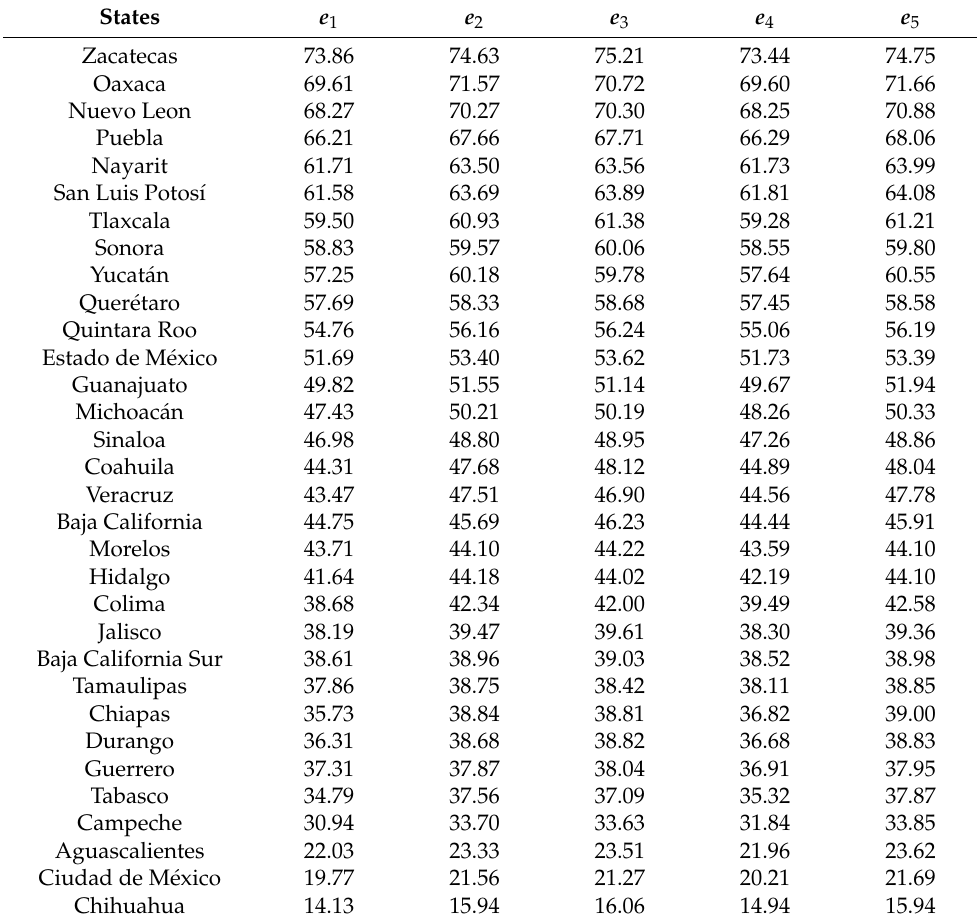
Table A5. Bon-IHOWA operator